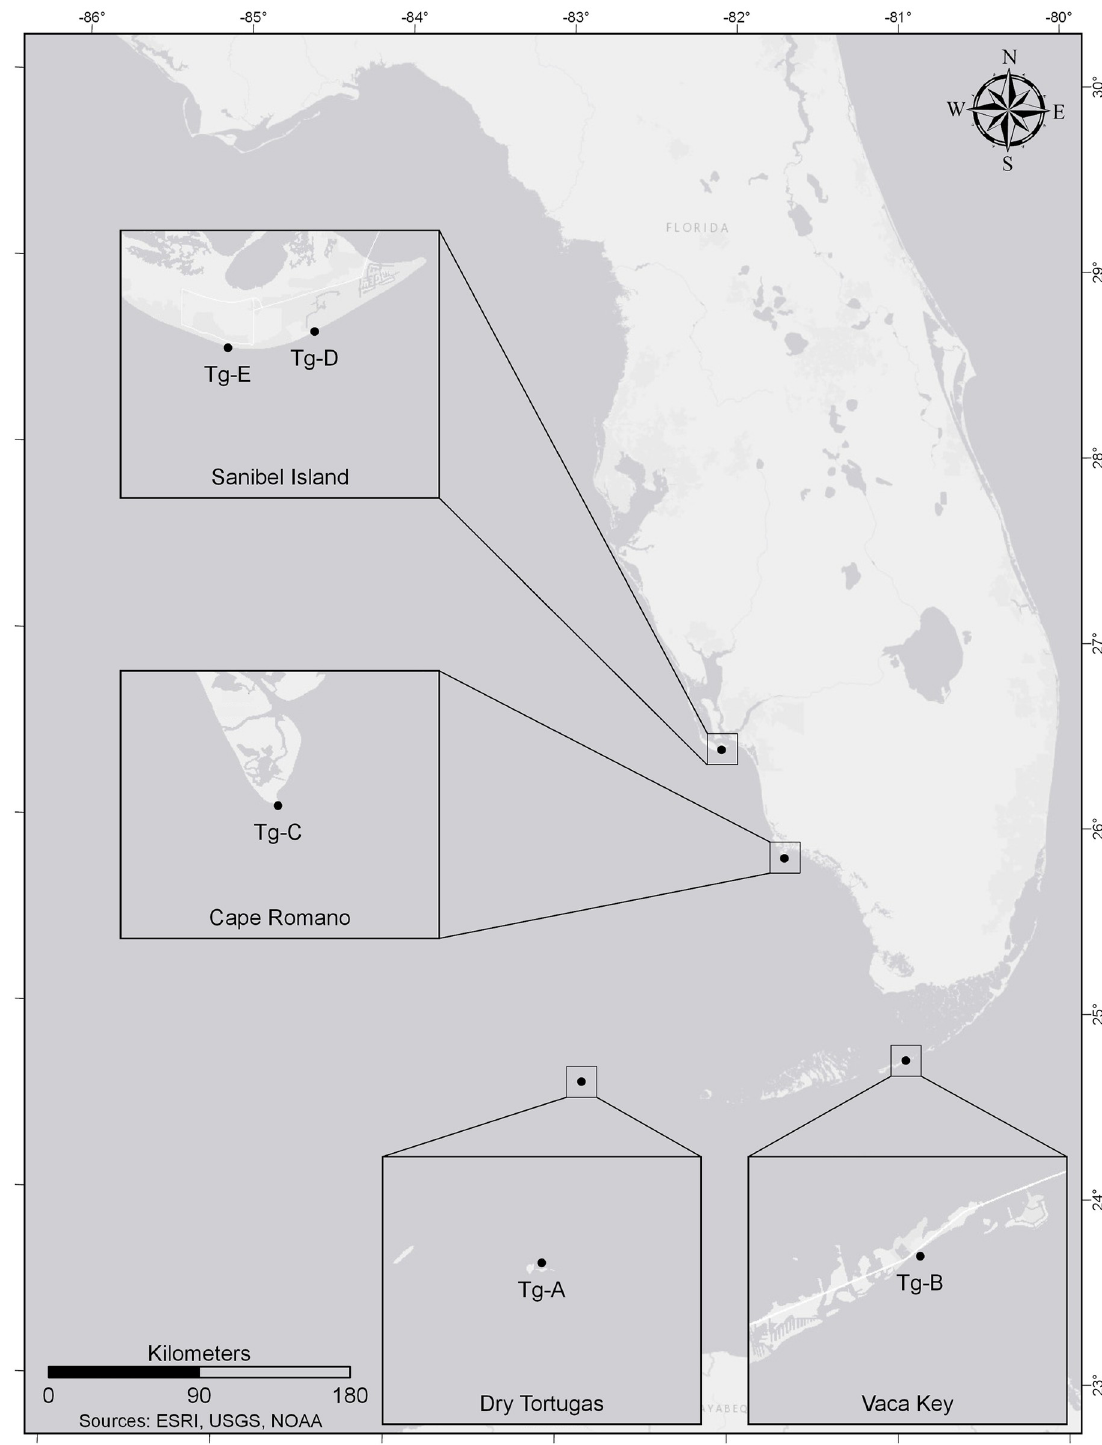
Fig 1. Map of sampling localities. Map of Florida, USA showing collection localities for shells of the Florida Horse Conch, Triplofusus giganteus , used for stable isotope